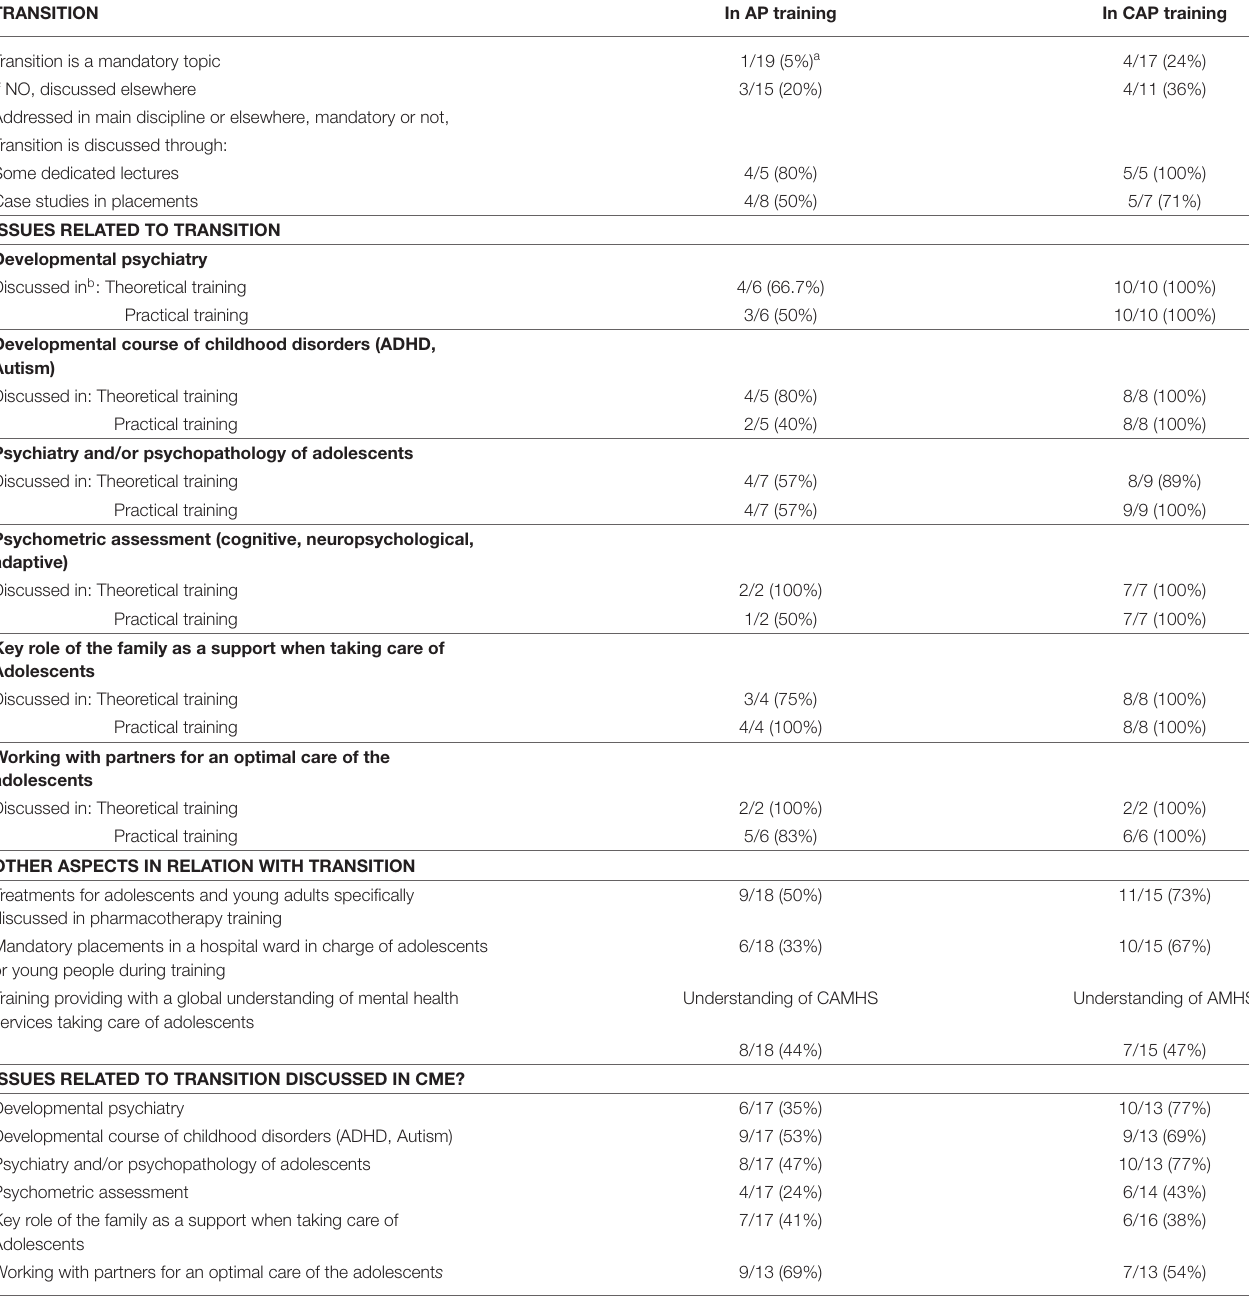
TABLE 1 | Transition and related issues in AP and CAP training and in Continuing Medical Education.